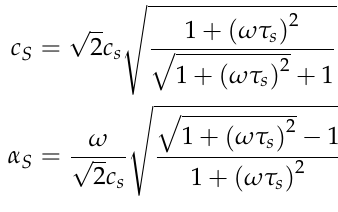
Figure 6. Acoustic pressure ( kg ∆ points per wavelength with irregular nodal